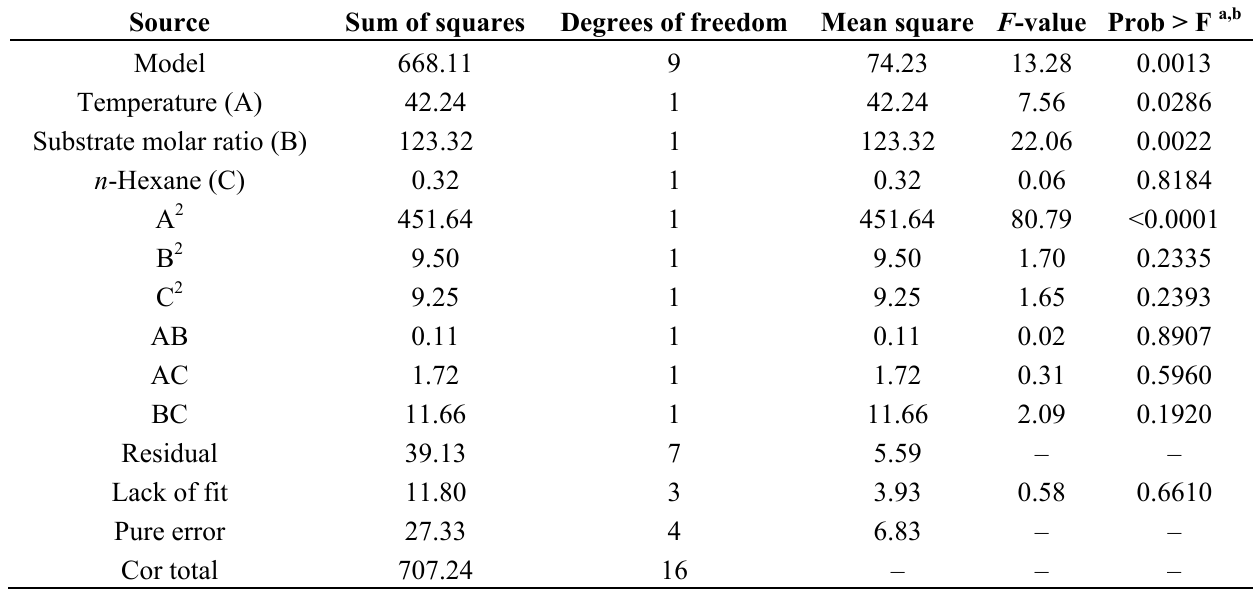
Table 3. ANOVA for joint test with waste cooking oil as a feedstock.